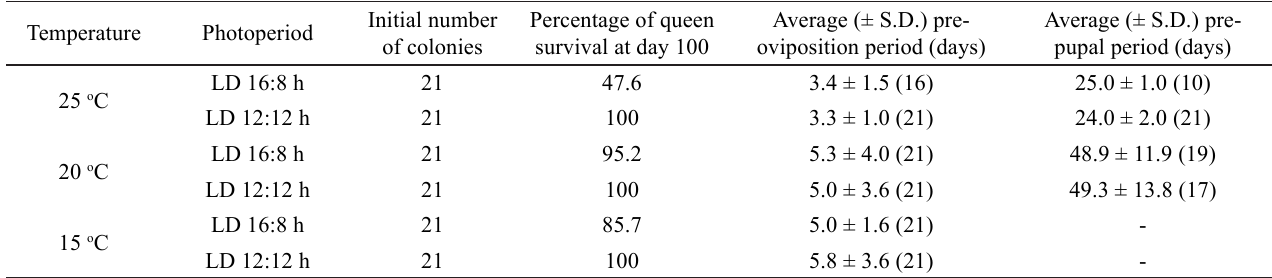
Number of queens starting to oviposit is shown in parentheses after the average pre-oviposition period. Number of colonies in which pupae emerged is shown in parentheses after the average pre-pupal period.